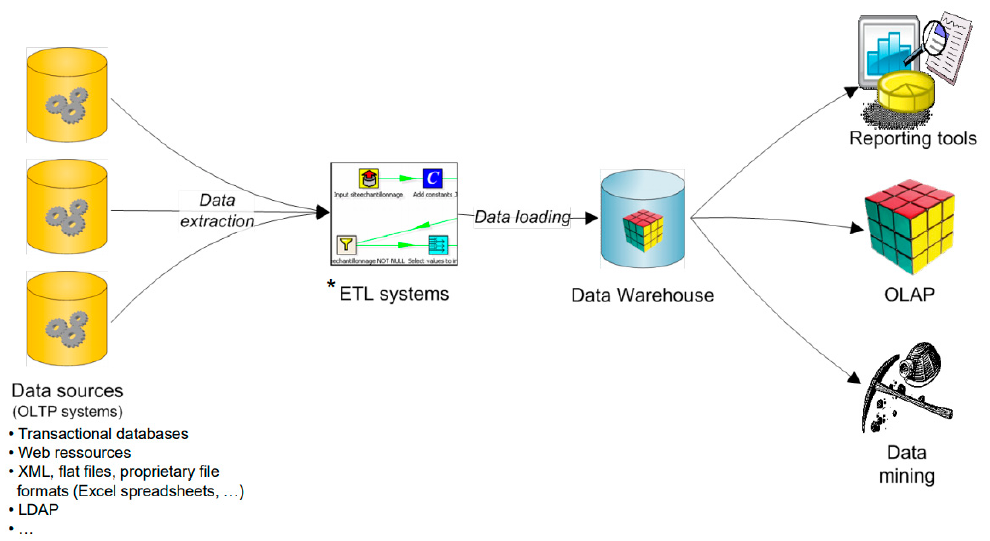
Figure 1. Classical architecture of business intelligence (BI) infrastructure [9]. Asterisk means “n” according to UML con- vention.